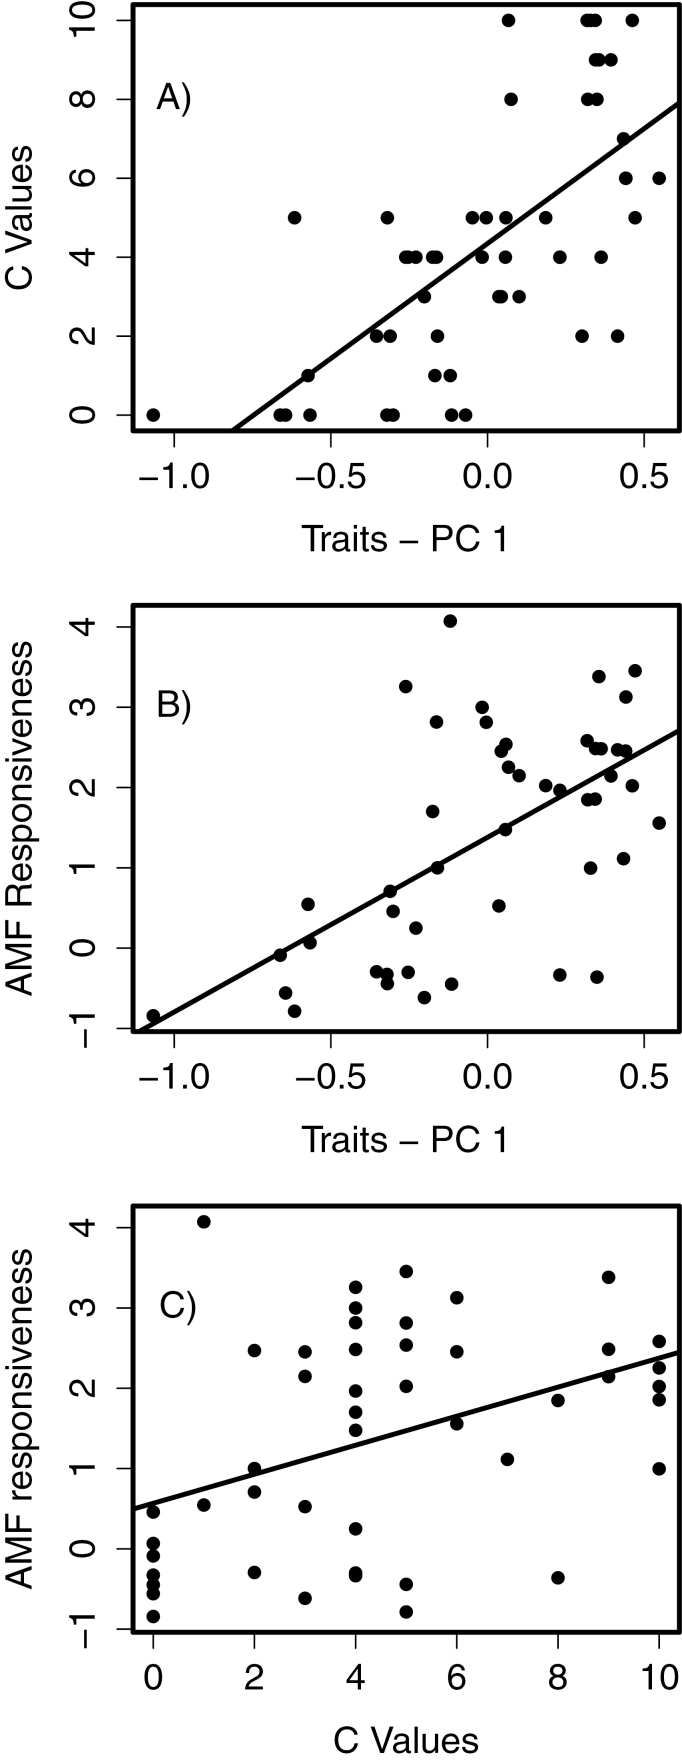
(A) C values and the first PC of species traits (Fig. 1) are significantly correlated (DF = 50, y = 5.8x + 4.3, P < 0.001, r2 = 0.45). Low scores on PC1 are correlated with traits typically of an early-successional life history and high scores are associated with late-successional traits. C values are from Rothrock and Homoya (2005). (B) Responsiveness of plant species to AMF as compared to the first PC of species traits (DF = 45, y = 1.38x + 1.38, P < 0.001, r2 = 0.35). (C) Species with high C values tend to be more responsive to mycorrhizal fungi (DF = 45, y = 0.18x + 0.57, P = 0.004, r2 = 0.17).